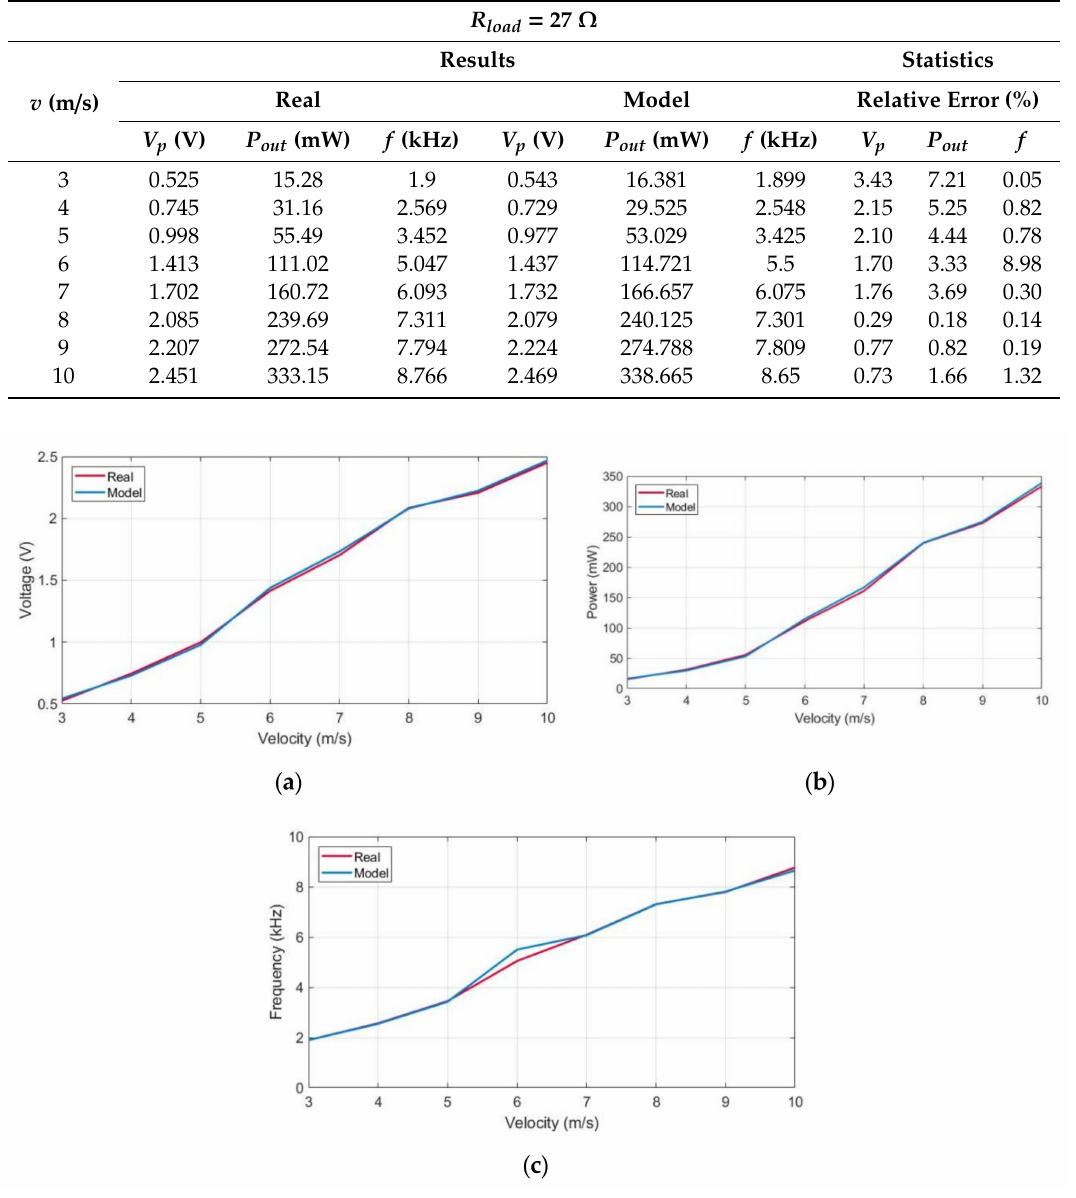
Figure 19. LTspice model vs. measured values comparison with a 27 Ω resistive load (impedance matching condition). ( a ) Simulated vs. measured voltage. ( b ) Simulated vs. measured power. ( c ) Simulated vs. measured power